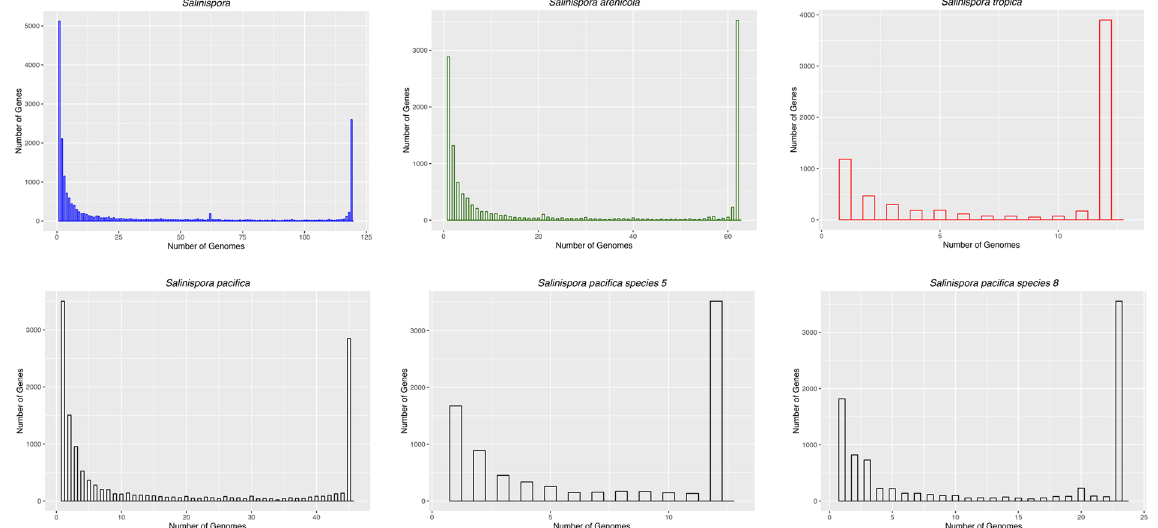
Figure 7. Numbers of orthologous groups found across all genomes (upper left), S . arenicola genomes (upper center), S . tropica genomes (upper right), S . pacifica genomes (bottom left), S . pacifica candidate species “ Sp1” (bottom center), S . pacifica candidate species “Sp2” (bottom right). The histograms were generated from the pan-genomes excluding singletons and recent